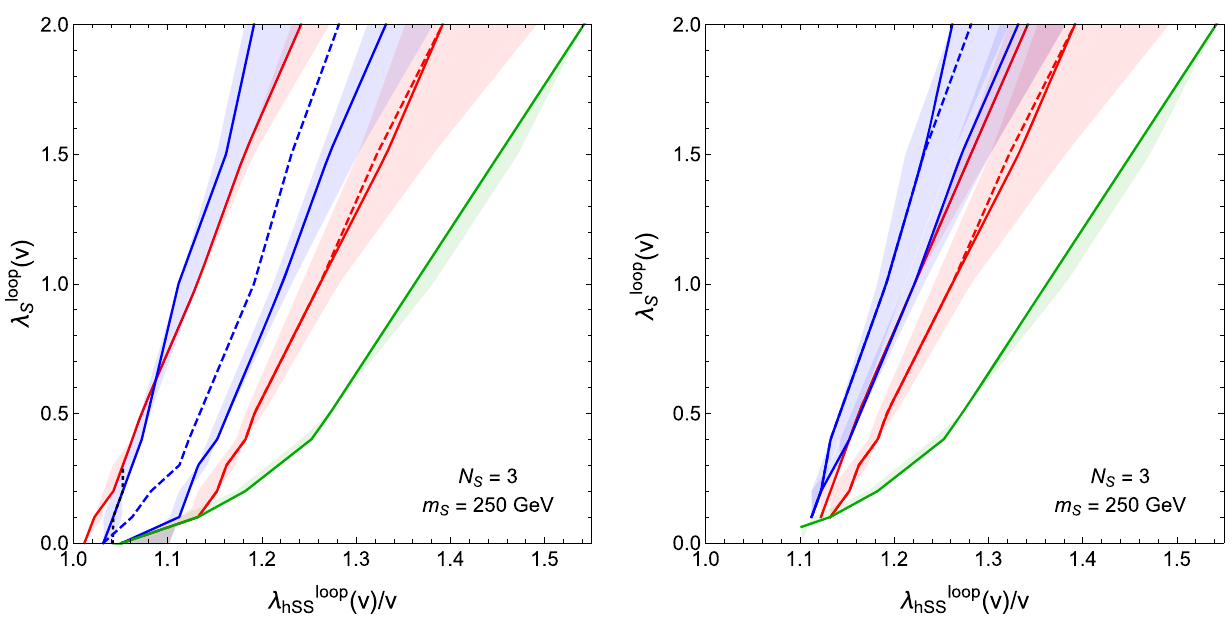
Fig. 5 SM + N S × S parameter space with a strong EWPT for N S = 3 and m S = 250 GeV. Region between solid red (blue) lines: regions with strong one-step PT satisfying v c / T c > 0 . 6 for the standard TFD (new PD) calculation on the left , and v c / T c > 1 . 0 on the right . To the left of these lines, the PT is weakly first order or second order. Between the red (blue) lines and the green line, the PT is two-step in TFD (PD) calculation. To the right of the green line, the EWSB vacuum is not